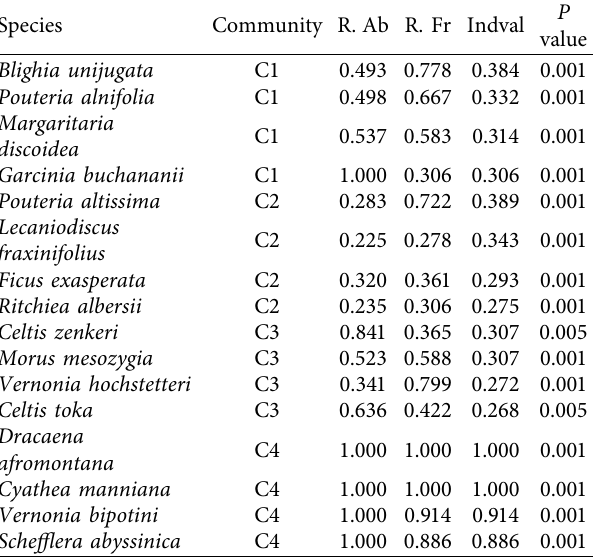
Table 6: Higher indicator values with signifcance of species in the